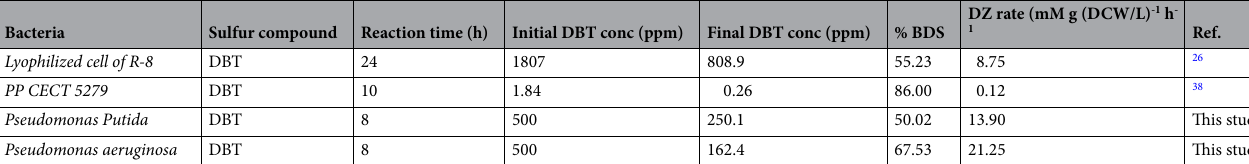
Table 3. Results of model diesel compared with literature.